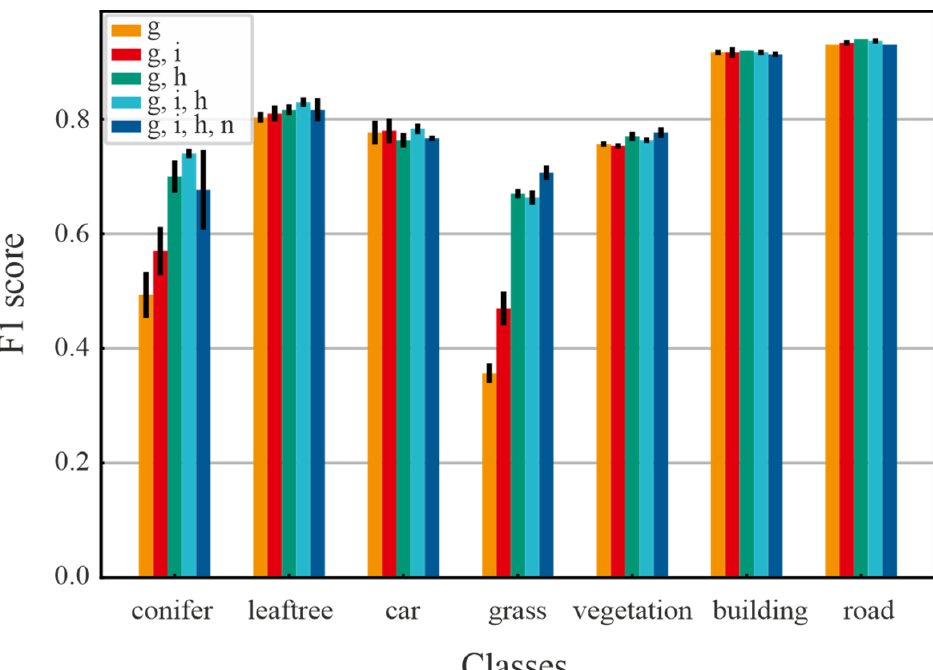
Figure A3. Visualization of the training results. Here the F1 score of each class is shown for the trainings using just geometry (g), geometry and intensity (g, i), geometry and DAV (g, h), geometry, intensity and DAV (g, i, h) and geometry, intensity, DAV and number of points (g, i, h, n). The black bars indicate the standard deviation calculated from the three separate trainings for each setting.